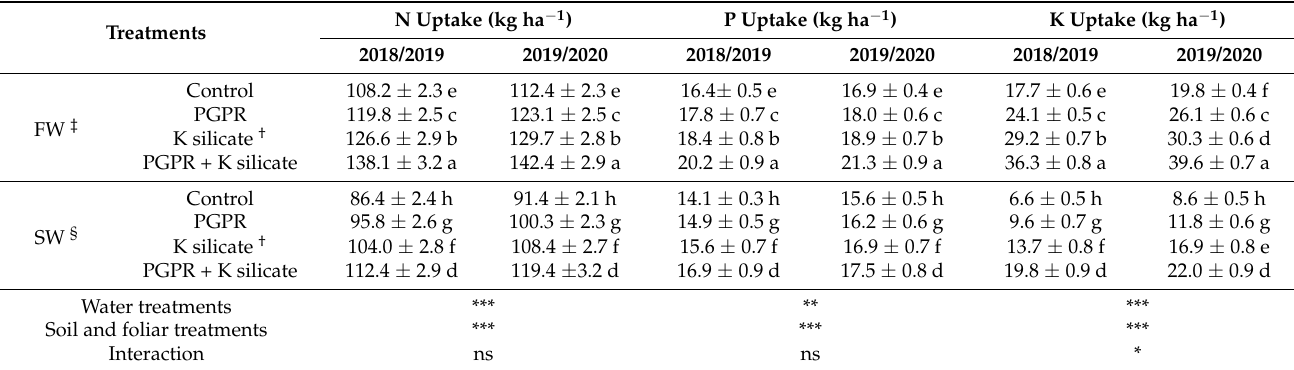
Table 2. Grain N, P and K uptake of faba bean plants irrigated with fresh and saline water in salt-affected soil in the presence of PGPR and potassium silicate during two growing seasons.